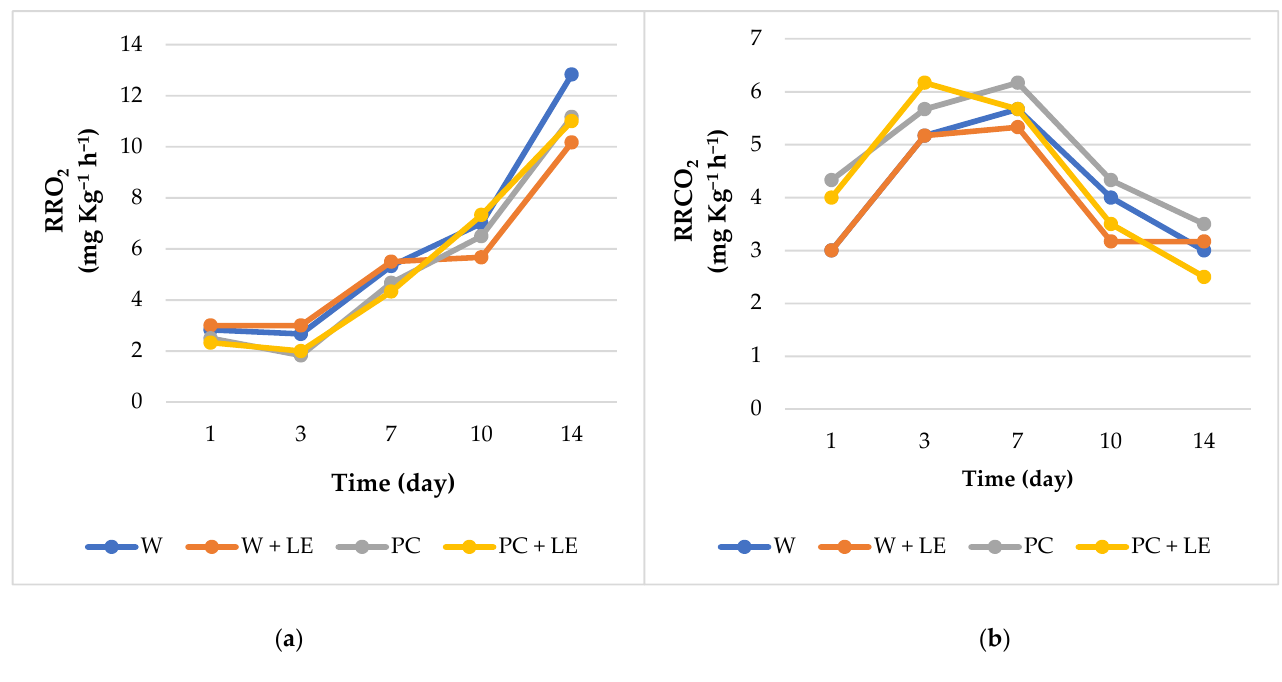
Figure 5. ( a ) Oxygen consumption values (RRO 2 ) of uncoated and coated fresh-cut carrots throughout 14 days of storage at 4 °C; ( b ) carbon dioxide production values (RRCO 2 ) of uncoated and coated fresh-cut carrots throughout 14 days of storage at 4°C. Abbreviations: W; W + LE; PC; PC + LE (see Table 1).